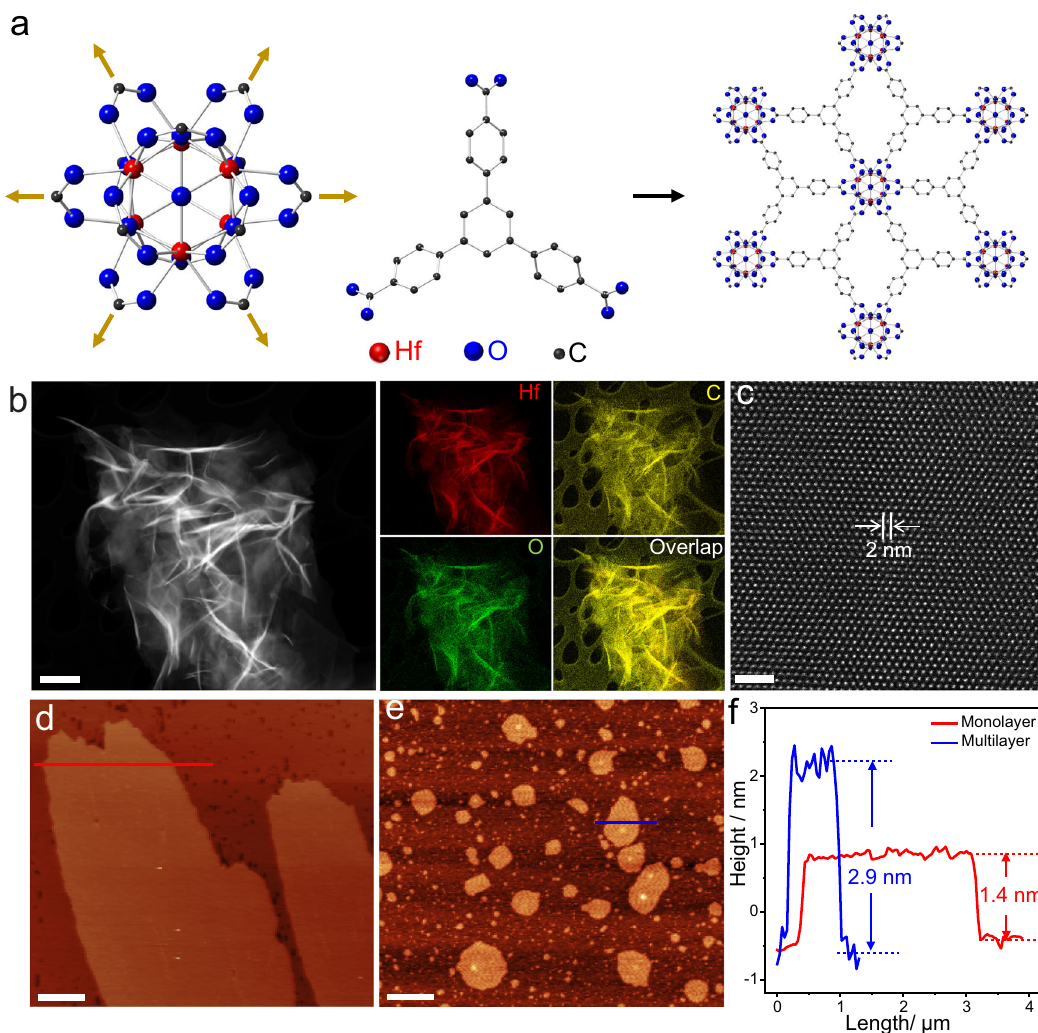
Fig. 1 | The bulk structure characterization and thickness measurement of Hf- MOLs nanosheets. a Schematic illustration of the construction of MOLs from 6-connected Hf-clusters and 3-connected BTB ligands with the connectivity indi- catedbygoldenarrows.TheelementsarerepresentedasHf,red;O,blue;C,black . b Representative HAADF-STEM image and the corresponding elemental maps of